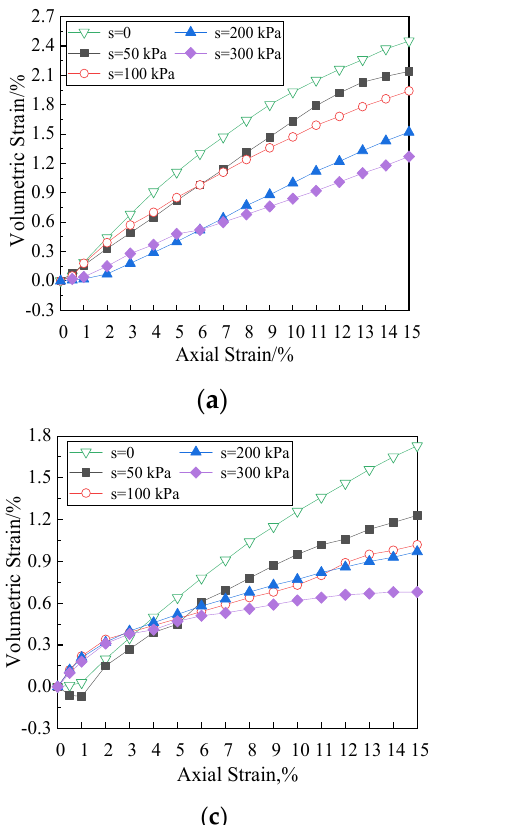
( b ) Figure 12. Effects of matric suction on volumetric strain vs. axial strain curves (net confining pressure = 100 kPa). ( a ) Fiber length = 6 mm, ( b ) fiber length = 19 mm. The volumetric strain of the failure specimens with the same matric suction and net confining pressure is taken as the average value to plot the curve, as shown in Figure 13. As can be seen from the figure, when the net confining pressure is constant, the volu- metric strain of the specimen decreases greatly whether the matric suction is large (greater than 100 kPa) or small (less than 50 kPa), but it has little decrease in the range of 50-100 kPa. The volumetric strain decreases with the increase in matric suction and net confining pressure, but it varies flat with matric suction relatively. According to the generalized suction principle proposed by Sun [26], the anti-deformation ability does not increase proportionally with the increase in matric suction, which indicates that part of the suction can increase the strength and anti-deformation ability. The volumetric strain of the specimen is more sensitive to the change in net confining pressure. Figure 14 is cloud diagram of volumetric strain with matric suction and net confining pressure. In short, the change trend of volumetric strain with matric suction and net confining pres- sure during the failing process of specimens can be intuitively seen.